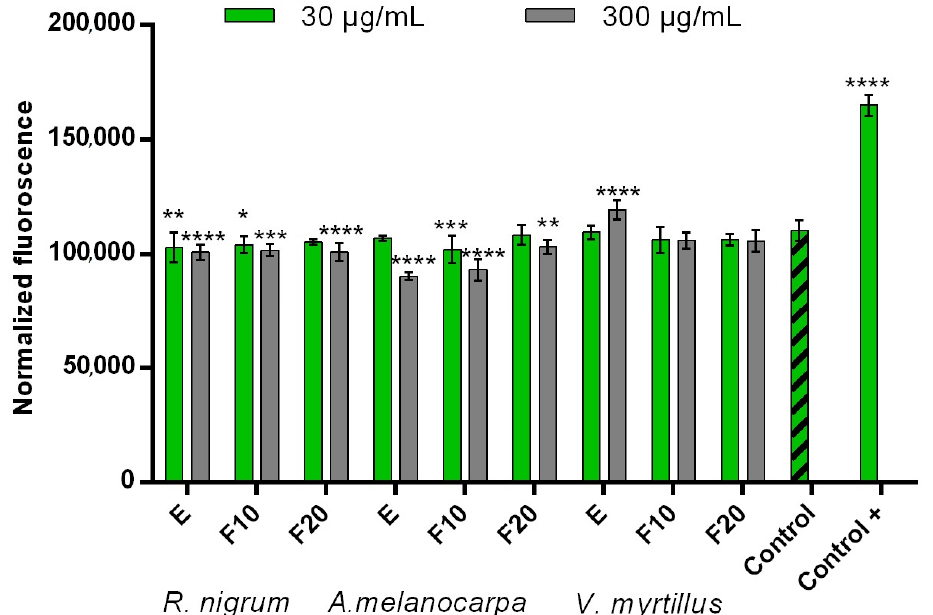
Figure 1. Intracellular ROS levels in HaCaT cells exposed to extracts (E) and ferments (F10 and F20) from R. nigrum , A. melanocarpa , and V. myrtillus . Data are the mean of three independent experiments in which each sample concentration was performed in triplicate. **** p < 0.0001, *** p < 0.001, ** p < 0.01, and * p < 0.05 compared to the control.